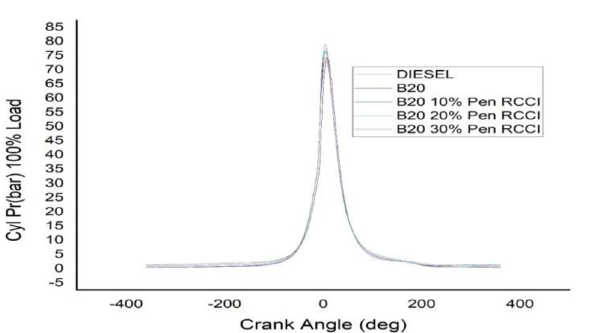
Figure 17. Cylindrical pressure at 100% load.